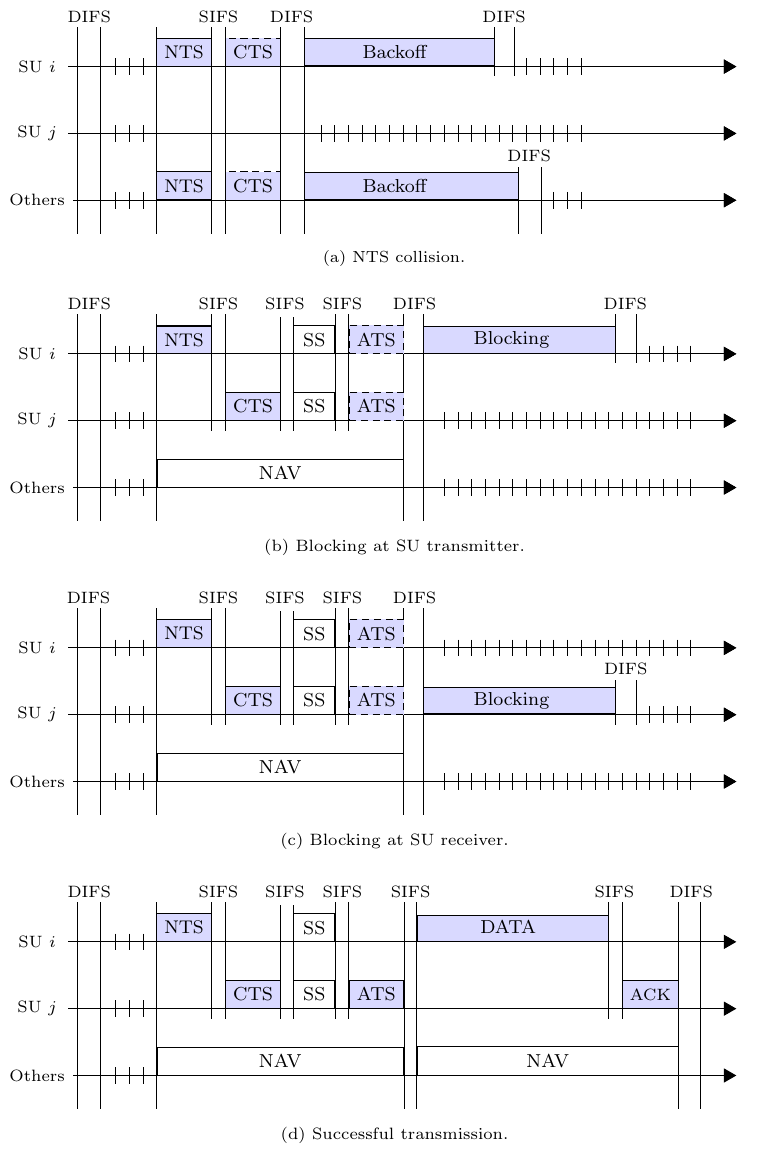
Figure 4. HSMA/CA access mechanism followed by the all possible